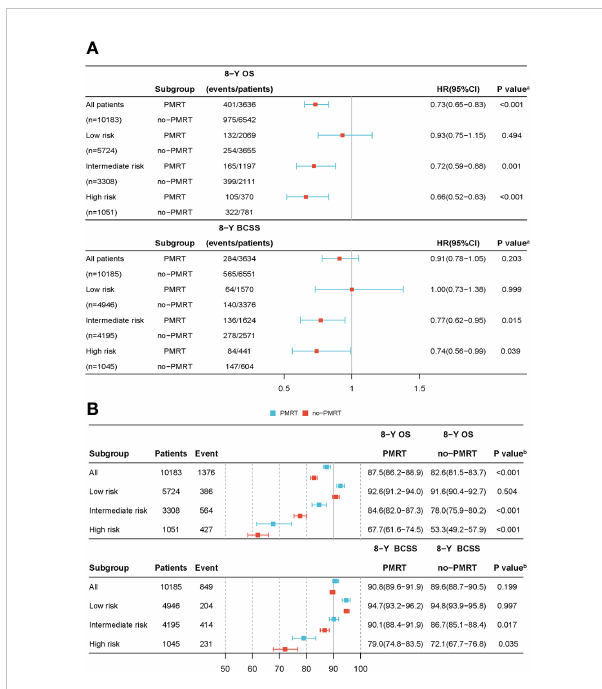
FIGURE 7 The forest plot of the IPTWs-adjusted cohort. The adjusted HR and 95% CI was calculated to estimate the effectiveness of PMRT use (A) in different risk groups after IPTWs. The adjusted Kaplan-Meier method was used to estimate OS and BCSS (B) rates between the PMRT and no-PMRT sets in various risk groups following IPTWs. (A) P value was calculated by Cox-regression; (B) P value was calculated by log-rank test. HR, hazard ratio; CI, con fi dence intervals; OS, overall survival; BCSS, breast cancer-speci fi c survival; IPTWs, stabilized inverse probability of treatment